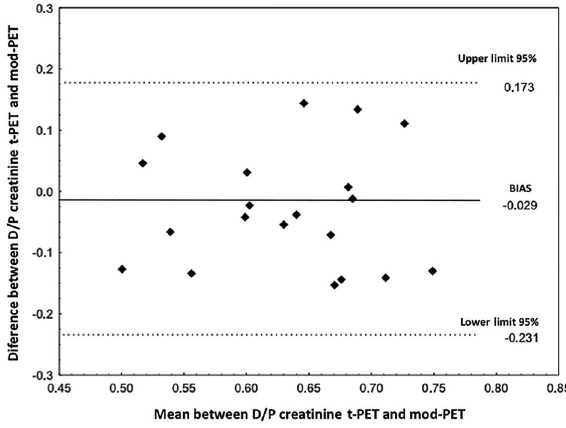
Figure 3. Bland-Altman analysis for dialysate-to-plasma concen- tration ratio (D/P) for creatinine between traditional peritoneal equilibration test (t-PET) vs modi fi ed (mod)-PET (n=20). There was no signi fi cant bias between t-PET and mod-PET ( – 0.029;